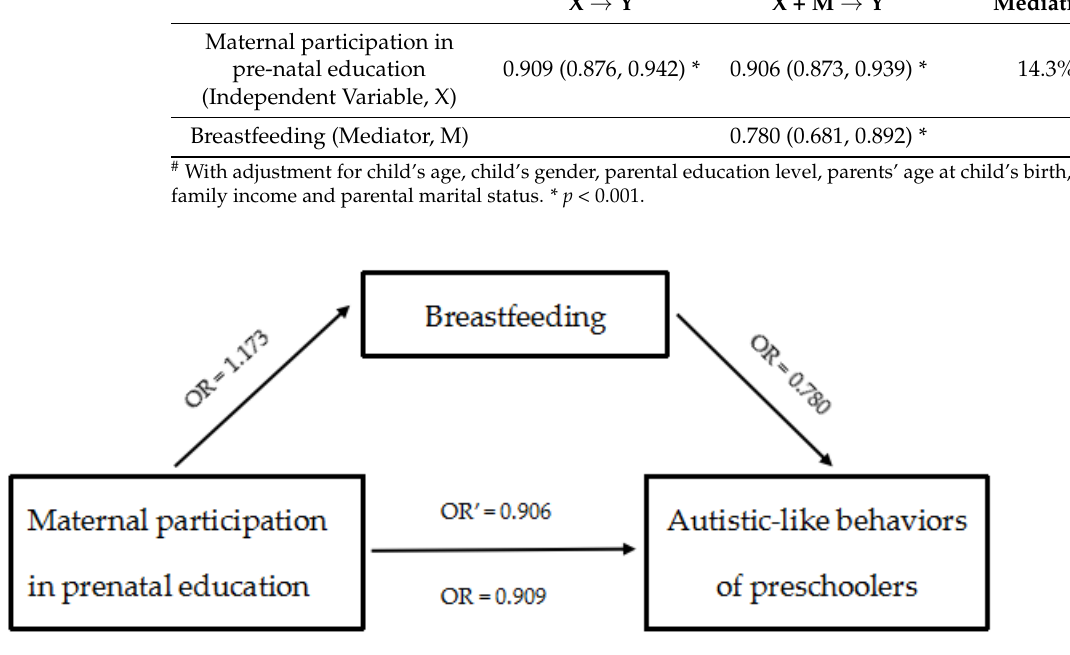
Figure 1. Steps of mediation